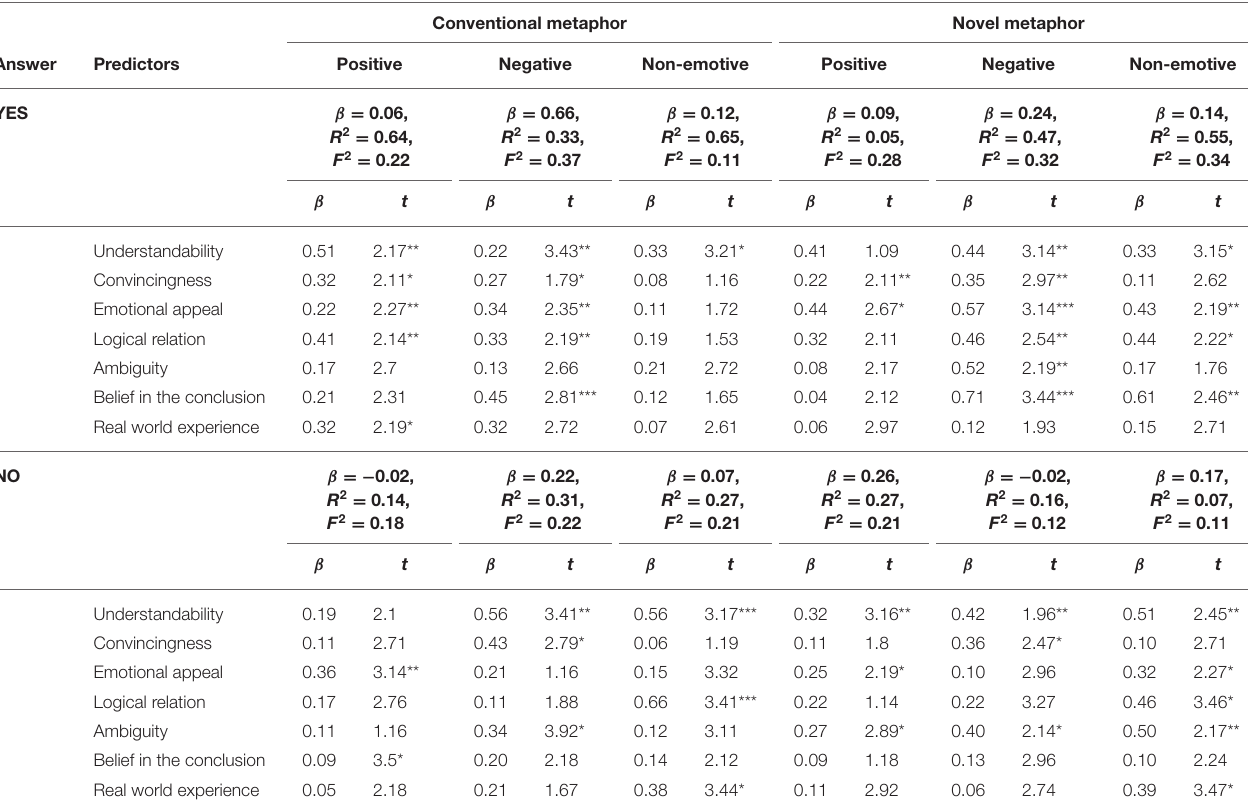
TABLE 6 | t/p -values for each predictor in the evaluation of arguments, comparing the middle term conditions (Experiment 1). Conventional